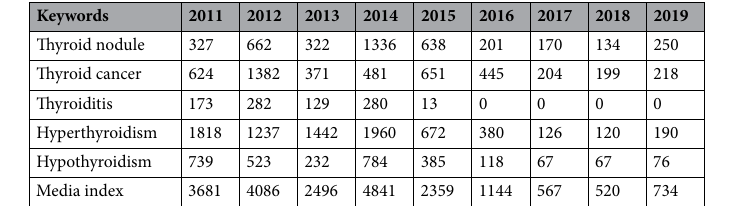
Table 3. Basic situation of media index from 2011 to 2019.